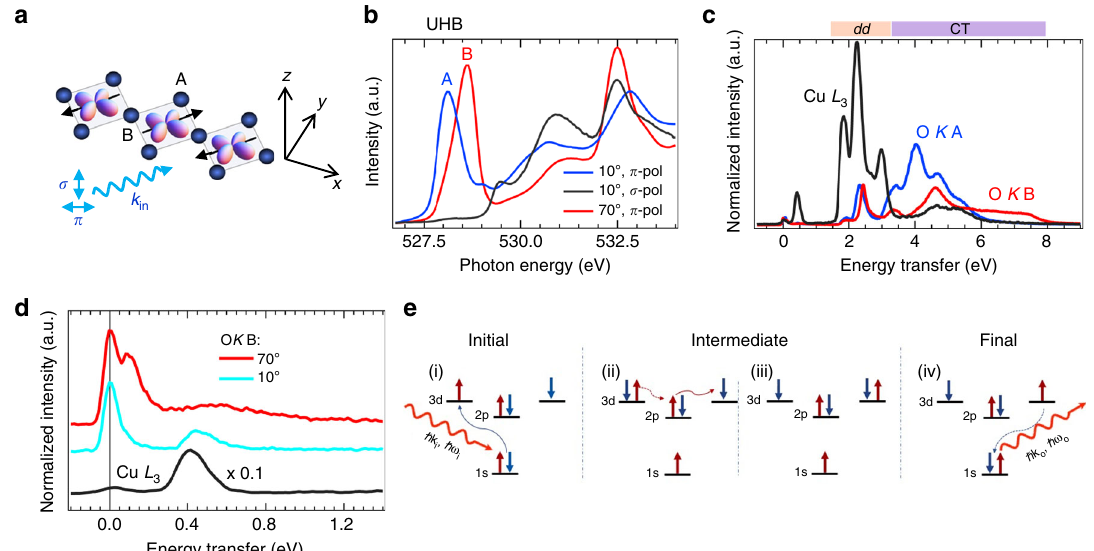
Fig. 1 Summary of the experimental data at the oxygen K -edge. a Cartoon sketch of the Cu-O-Cu corner-shared chains forming the active low-energy degrees of freedom in Sr 2 CuO 3 , and of the incident-light geometry. The Cu atoms are primarily in a d 9 valence state, where a single hole occupies each of the Cu 3 d x 2 (cid:1) y 2 orbitals and interacts antiferromagnetically with its in-chain neighbours. b The polarization dependence of the XAS spectra. σ -polarized light (black solid line) probes unoccupied states perpendicular to the CuO 4 -plaquettes, having no spectral weight at the UHB (there are no apical oxygens). Data obtained with π -polarized light at incidence angles of 10° (grazing incidence geometry, blue line) and 70° (close to normal incidence, red line) primarily probes the out-of-chain (A) and in-chain (B) oxygen sites, respectively. The difference in the pre-peak resonance corresponds to the differences in the chemical environments of these two oxygen sites (chemical shifts), where the B site hosts the plaquette-connecting oxygen orbital 33 . c Polarization dependence for π -polarized O K -edge RIXS data for incident energies tuned to the A (blue) and B (red line) peaks in the XAS shown in b . Incident angles as in b : 70° (10°) corresponds to q ≈ 0 ( q ≈ π /2 a ). The π -polarized Cu L 3 -edge RIXS data at 20° incidence angle ( q ≈ π /2 a ) is also shown for comparison (black line). The RIXS spectra are normalized to acquisition time. The peaks above 1.8 eV energy transfer are associated to dd (orbiton) and charge transfer (CT) excitations, as indicated. The peak below 0.6 eV in the Cu L 3 data corresponds to multi-spinon excitations 4 . d The Cu L 3 and O K B-resonance RIXS data from c and B-resonance for 10° incidence angle ( q ≈ π /2 a , turquoise line), now focusing on the fi rst 1.3 eV in energy transfer, where several low- energy spin excitations are found. The RIXS data are reported in arbitrary units (a.u.). e Sketch of the double spin- fl ip process across two Cu sites at